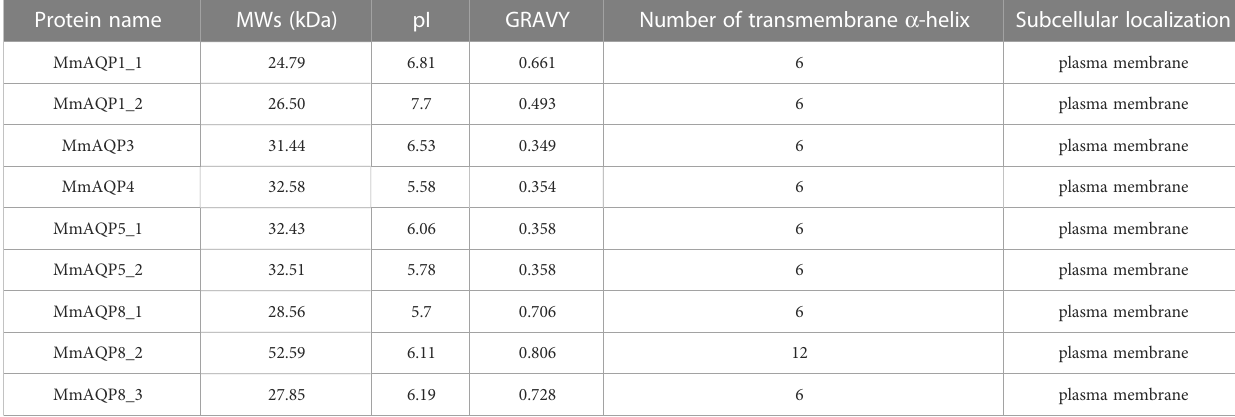
TABLE 1 Physicochemical properties of